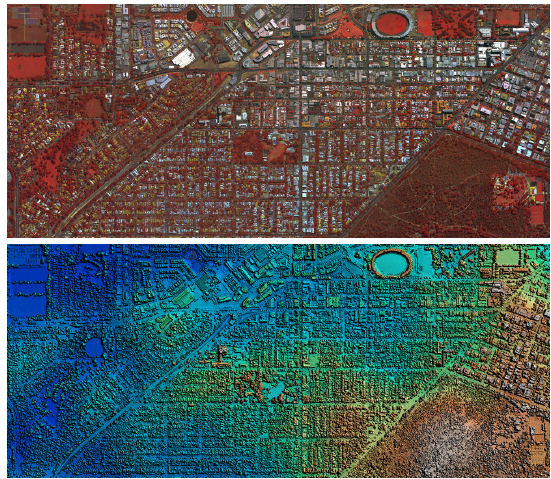
Figure 6. The region used to guide parameter choices for the coastal plain. Shown is a false colour display (above) and sun- shaded DSM (below). Dimensions: 3 . 4 km by 1 . 4 km . Grey colours correspond to high elevations ( ∼ 63 m ), cool colours cor- respond to low elevations (blue ∼ 10 m